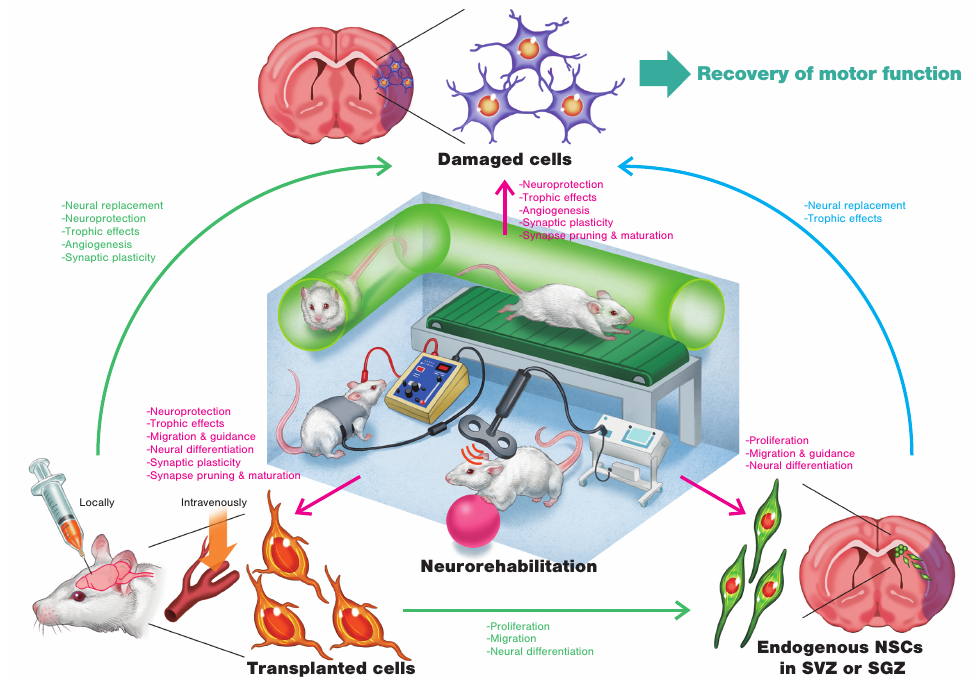
Figure 1. Schematic illustration of regenerative rehabilitation for stroke recovery in an animal model. Possiblemechanismsofactionrelatedtocelltherapyandneurorehabilitationaredescribed. Transplanted cells a ff ect endogenous neural stem cells (NSCs) in the subventricular zone (SVZ) or the subgranular zone (SGZ), as well as damaged cells in the infarct area. Neurorehabilitation such as treadmill exercise, enriched environment (EE) interventions, repetitive transcranial magnetic stimulation (rTMS), and transcranial direct current stimulation (tDCS) not only a ff ects damaged cells but also a ff ects endogenous NSCs and transplanted cells. Combining cell therapy and neurorehabilitation will be able to induce synergistic e ff ects on motor